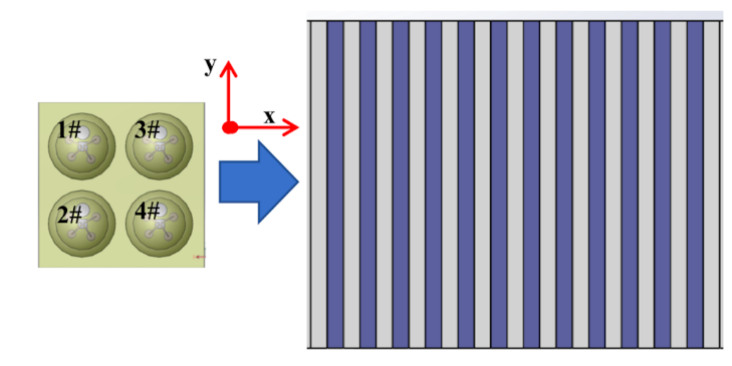
Figure 6. Tactile sensor sliding across the ridge texture sample. The processing flow of the raw output signal of sensing cell 3# is shown in Figure 7. The sample used is the S31 sample with a ridge height of 0.9 µ m, a ridge width of 300 µ m, and a spatial period of 2000 µ m. Due to the inevitable irregular jitter of the linear stage during the sliding experiment, the signal exhibited a baseline drift phenomenon, as shown in Figure 7a. The signal passed through a high-pass filter with a cut-off frequency of 1 Hz to remove low-frequency interference, and we obtained the original signal with a baseline at 0, as shown in Figure 7b. After inputting the original signal and the Gaussian white noise with a certain noise intensity into the bistable system stochastic resonance model based on the Langevin equation, the first-order ordinary differential Equations (2) and (3) are solved by the fourth-order Runge–Kutta algorithm. The proper noise intensity of Gaussian white noise can make the output signals have a larger signal-to-noise ratio (SNR, hereafter), but because the amplitude difference of the input signals is small and the optimal SNR of output is not the goal, we selected the same noise intensity through prior experiments and generated the noise signal with the Matlab function. The signal processed by SR is shown in Figure 7c, and its signal characteristic has been significantly enhanced. Since the signals have obvious characteristics, the time interval ∆ t can be easily obtained through correlation analysis with the processing result of the signal generated by sensing cell 1#. The frequency-domain signal obtained by FFT processing contains the principal frequency information f prin and its amplitude information A . The difference between the two states of the time-domain signal is obvious, but there is still a certain amount of noise that interferes with the acquisition of texture information. Passed the randomly intercepted signal segment through a software-designed threshold comparator with a threshold of 1 V to obtain a state-unified signal, as shown in Figure 7d. The ratio of the high-level state of the signal segment to the level period is calculated and mapped to the ratio n of the ridge width to the spatial period in the ridge texture. The texture feature information of the corresponding sample can be figured out by combining the parameter results obtained